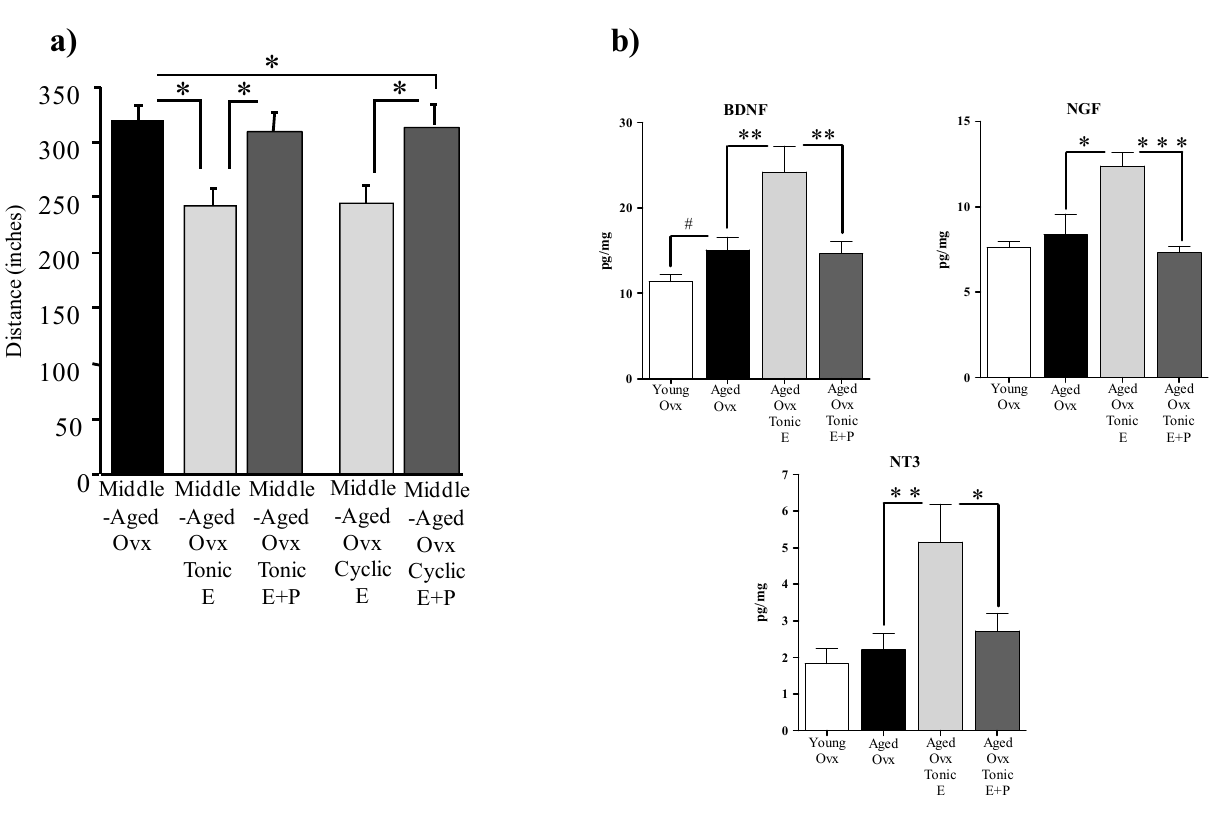
Figure 5. Progesterone reverses 17 β -estradiol’s effects on spatial memory and neurotrophins [97,184]. a) Mean ± SE distance-to-platform (inches) on the Morris maze task for each treatment group. Tonic and cyclic 17 β -estradiol treatments enhanced spatial reference memory performance in middle-aged Ovx rats, while the addition of progesterone reversed these beneficial cognitive effects. *p < 0.05. b) Mean ± SE protein levels of BDNF, NGF, and NT3 in entorhinal cortex for aged Ovx rats receiving no hormone (Aged Ovx), a 17 β -estradiol pellet (Aged Ovx E), a 17 β -estradiol pellet plus two progesterone pellets (Aged Ovx EP), and a young group also receiving Ovx surgery, with no hormone treatment (Young Ovx). Findings suggest that for all three neurotrophins, 17 β -estradiol increased protein levels, while the addition of progesterone reversed these increases.# p < 0.07; * p < 0.05; ** p < 0.01; *** p <